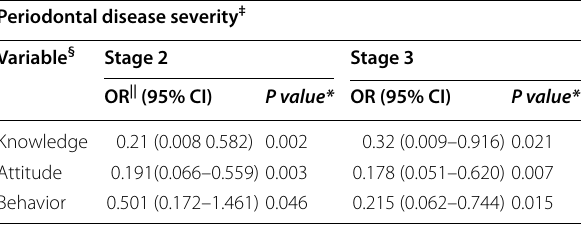
Table 4 Associations between dental nutrition knowledge, attitudes, and behaviors and periodontal disease in low‑income women ( n 222), Central Texas, June–December 2018 †